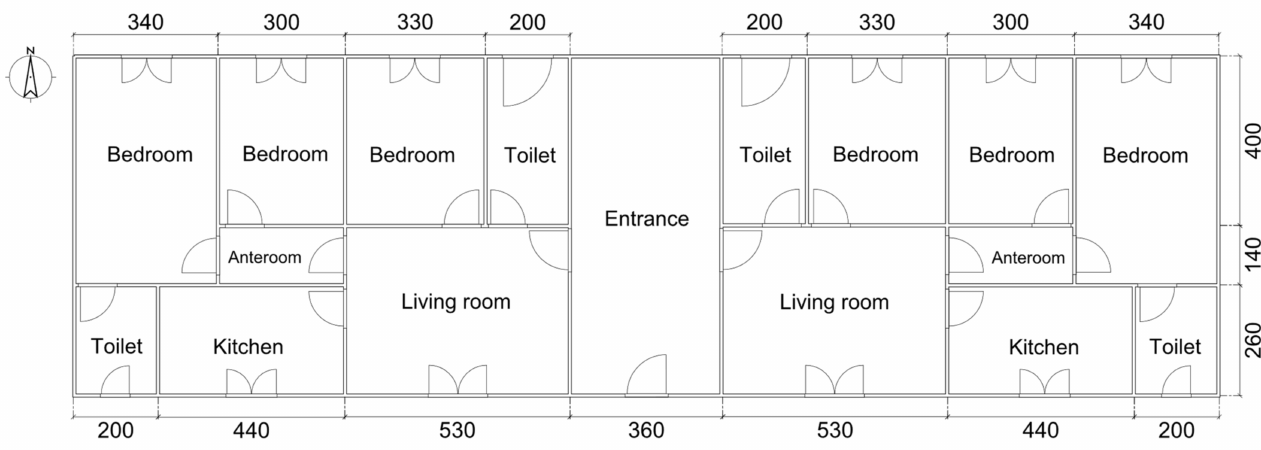
Figure 2. Plan views of one storey of the benchmark apartment block (dimensions in